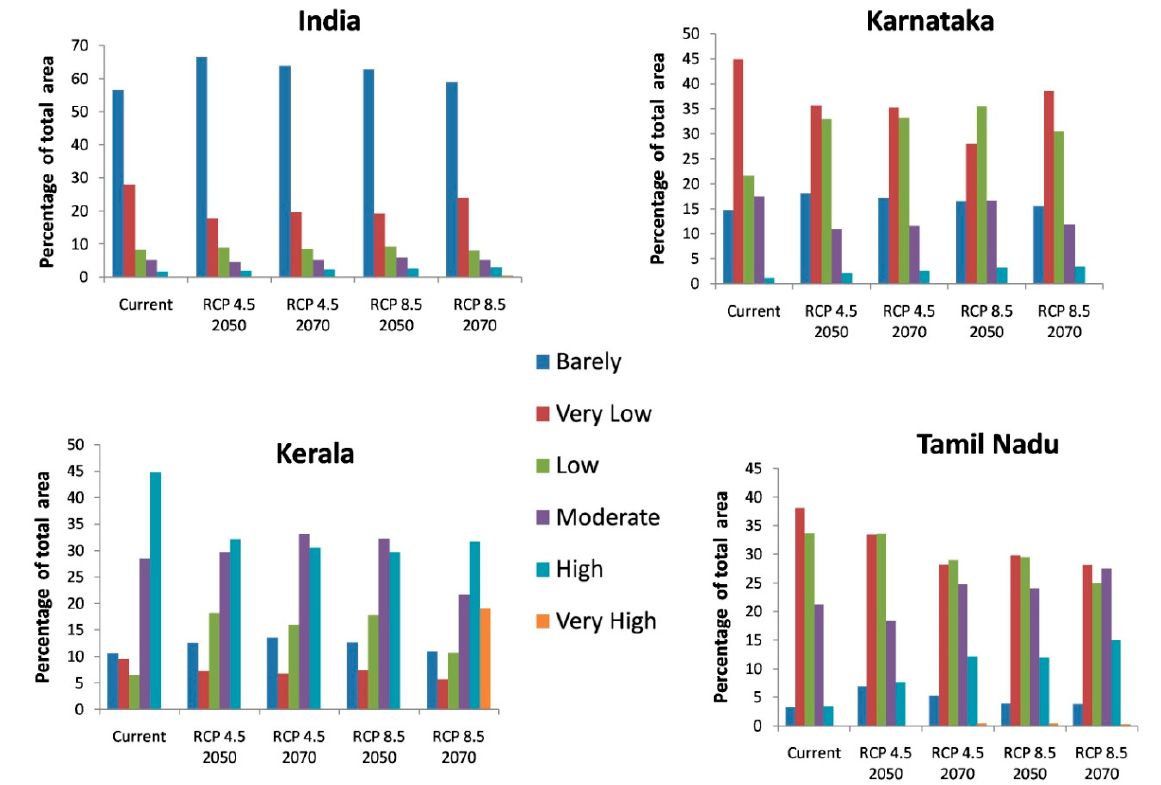
Figure 9. Percentage of total predicted area under different classes for the current and future climate of the study area of India and the regional levels of Karnataka, Kerala, and Tamil Nadu.